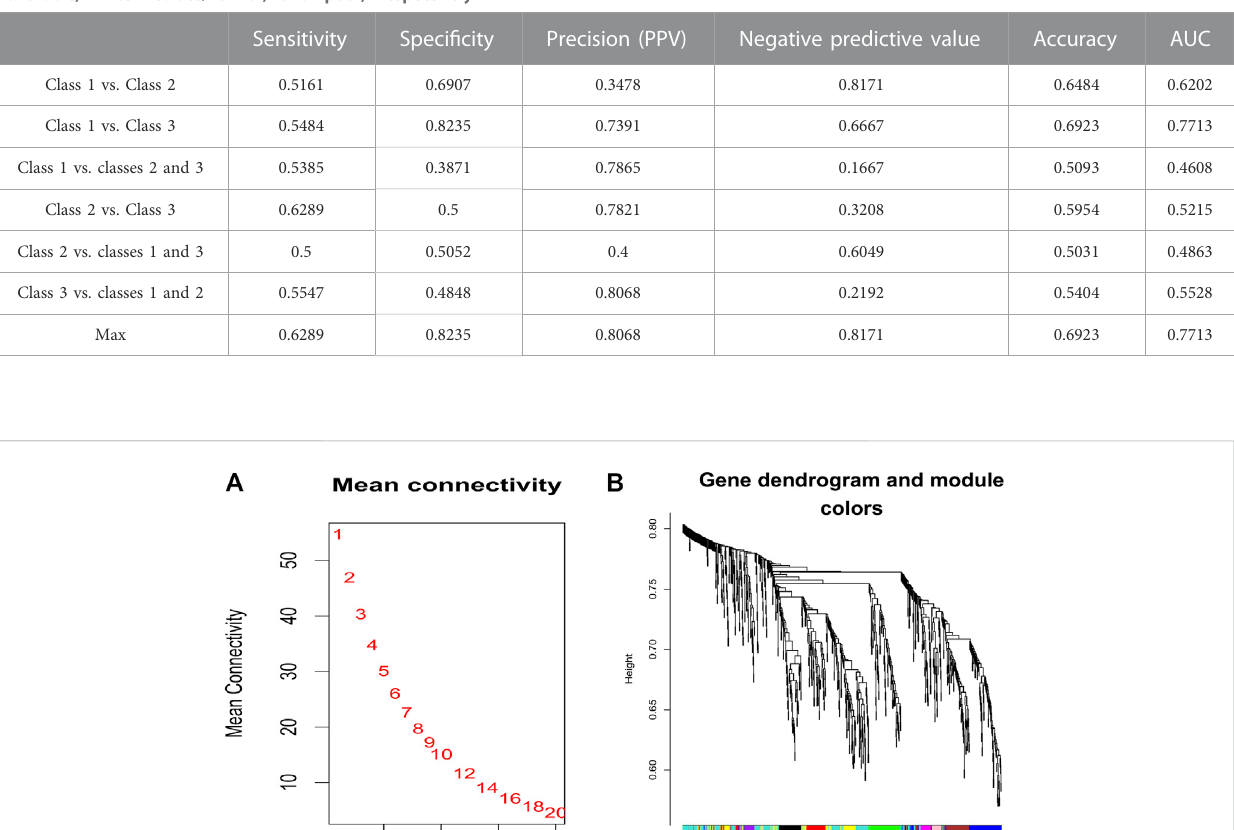
TABLE 1 Predictive performance of classi fi cation for each pairwise class using the proposed method in LAML multi-omics data, where classes 1, 2, and 3 denote “ favorable, ” “ intermediate/normal, ” and “ poor, ” respectively.